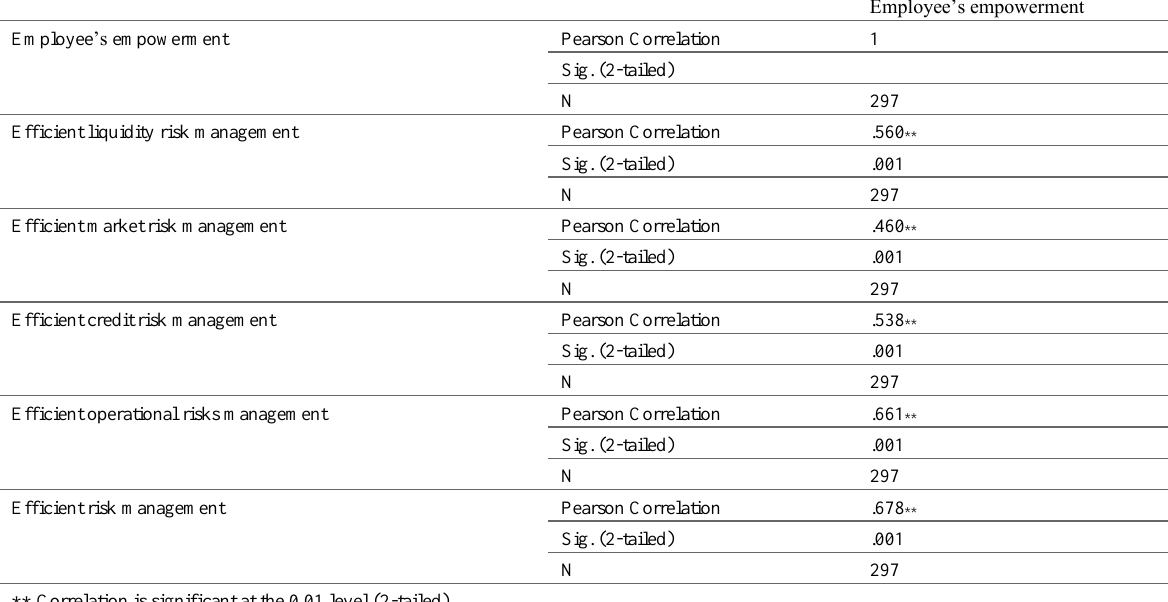
Table 6: Correlation between employee’s empowerment and efficient risk management as whole